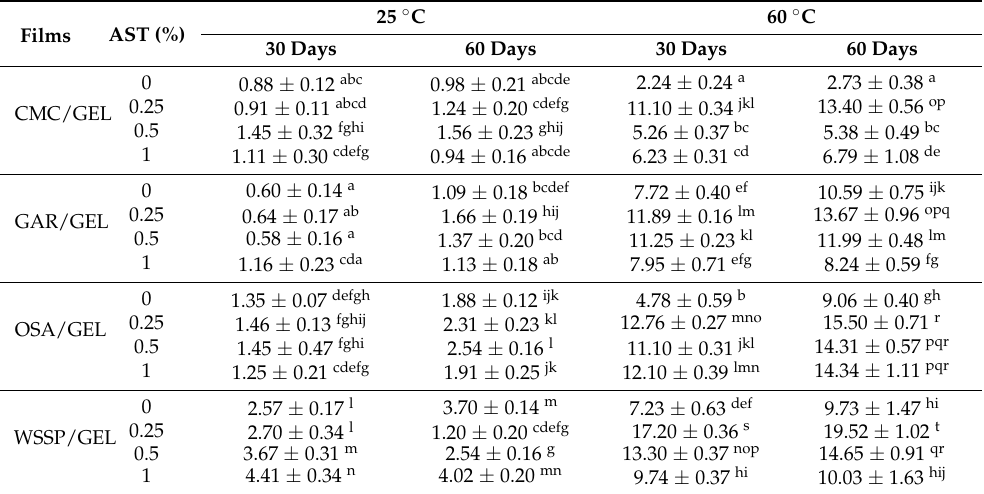
Table 2. The total colour differences during storage ( ∆ E) of 75/25 blend films obtained from polysac- charides: carboxymethyl cellulose (CMC), gum Arabic (GAR), octenyl succinic anhydride-modified starch (OSA), water-soluble soy polysaccharides (WSSP), and gelatin (GEL) incorporated increasing Astasana (AST)